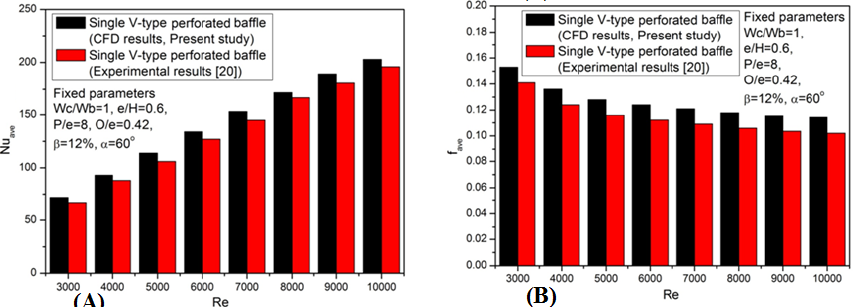
Figure 5. Comparison of experimental results with CFD results of single V-type perforated baffle: ( A ) Nu ave and ( B ) f ave .